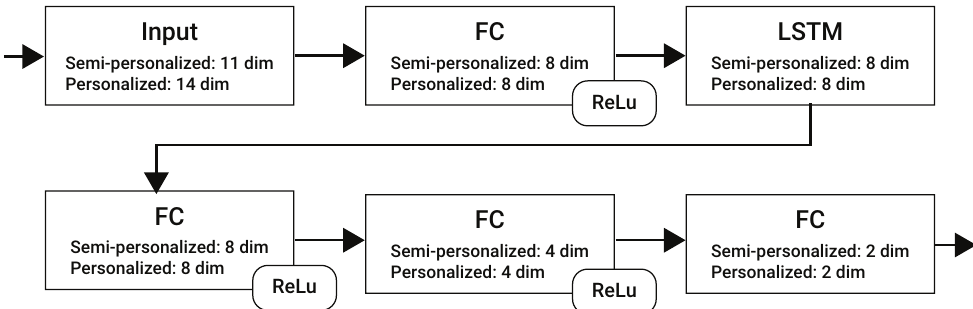
Figure 2. A schematic view of the RNN model’s architecture, as obtained using the AutoKeras library